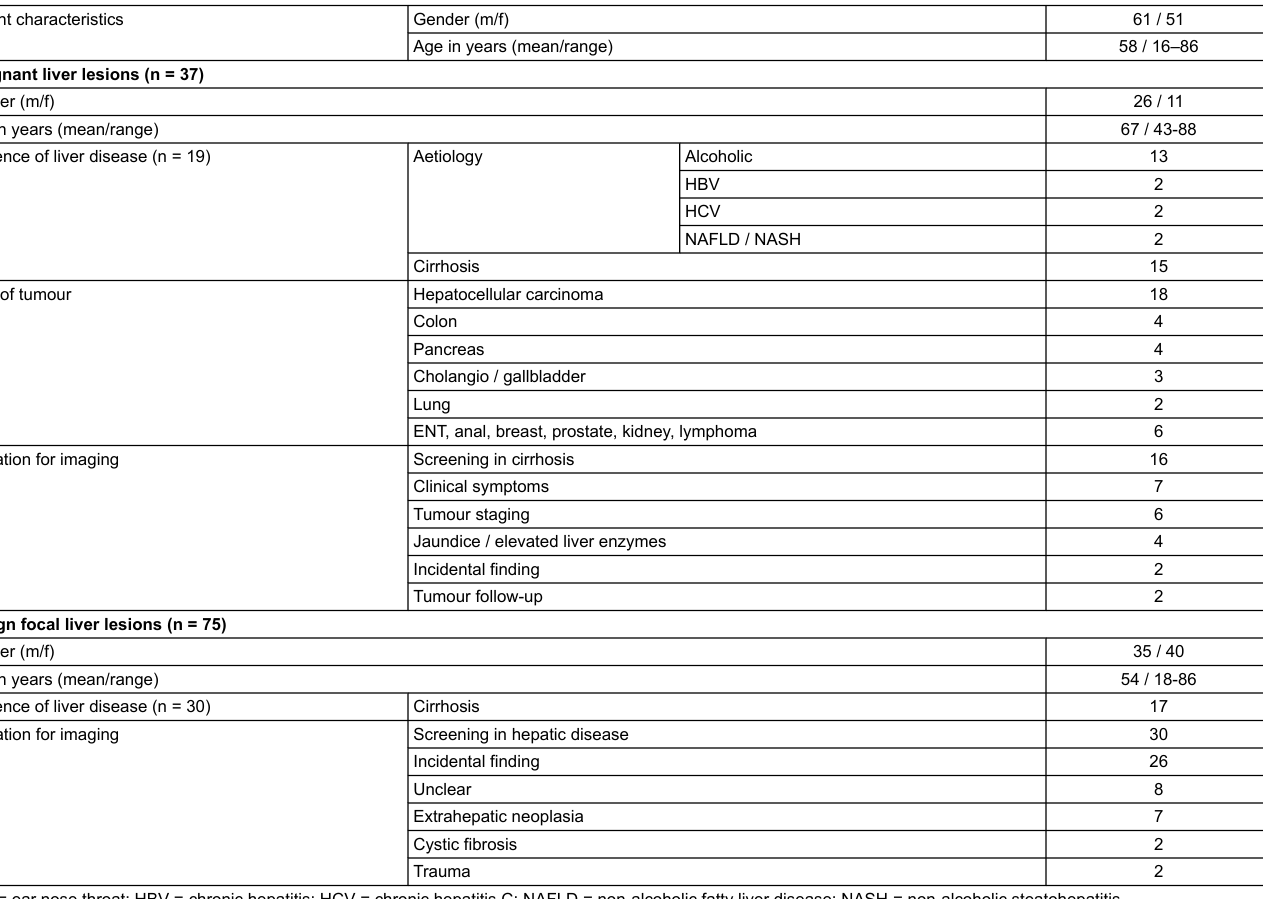
Table 2: Patients characteristics (n = 112).